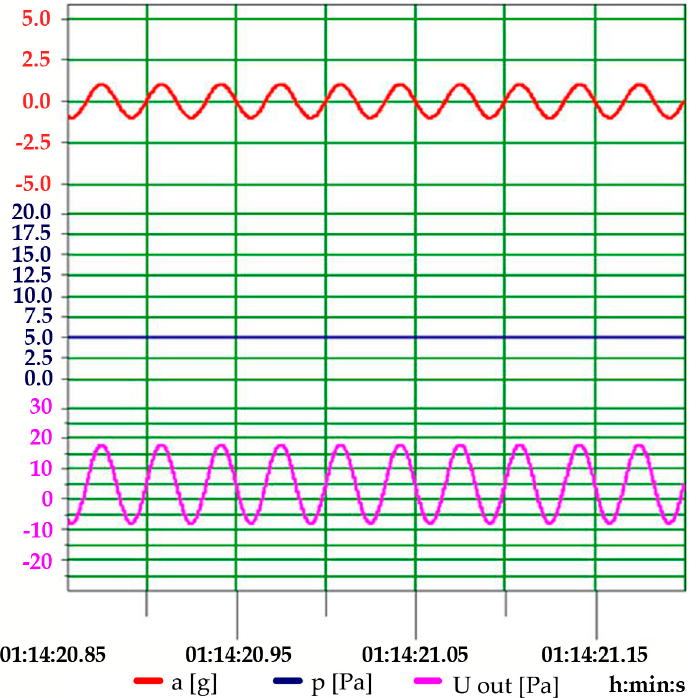
Figure 9. Waveforms of the experimental values of acceleration (a), pressure (p), and output signal (U out ) for dynamic acceleration with vibrations and with an amplitude of 1 g, frequency of f = 30 Hz, and pressure excitation of p = 5 Pa.